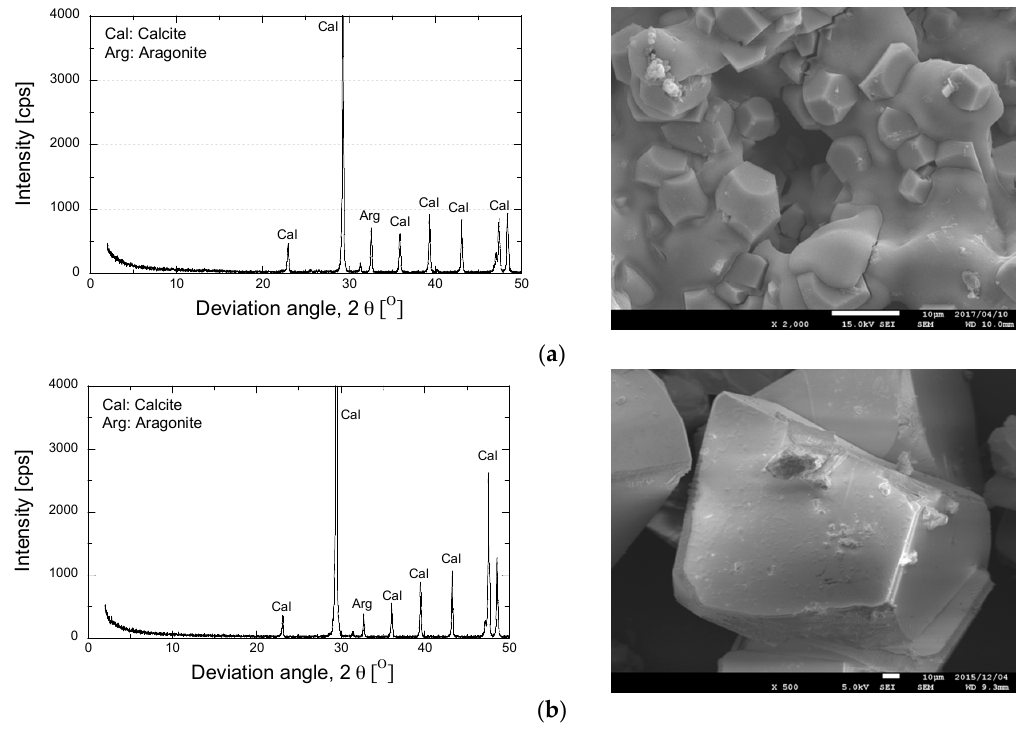
Figure 10. Results of mineralogy and morphology analyses of precipitated minerals. ( a )Treated solution; ( b )EMCP crystal/non-treated solution [34].